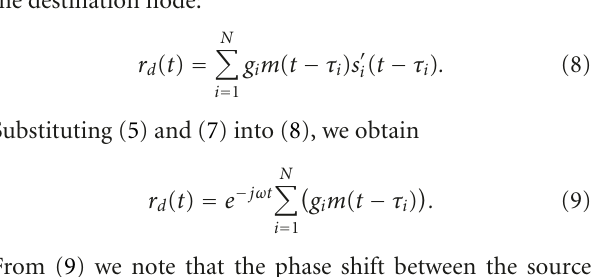
Figure 2: Time slots structure for TDD